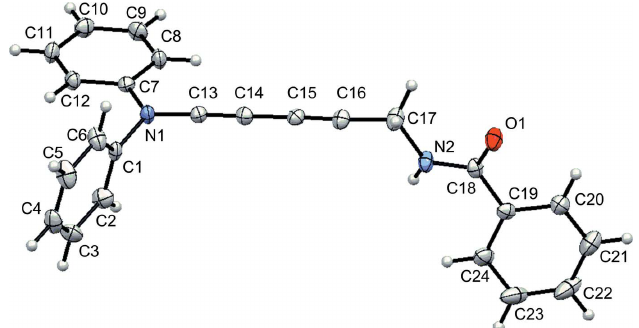
Figure 1 The molecular structure of the title compound, with displacement ellipsoids drawn at the 50% probability level and H atoms shown as small spheres.